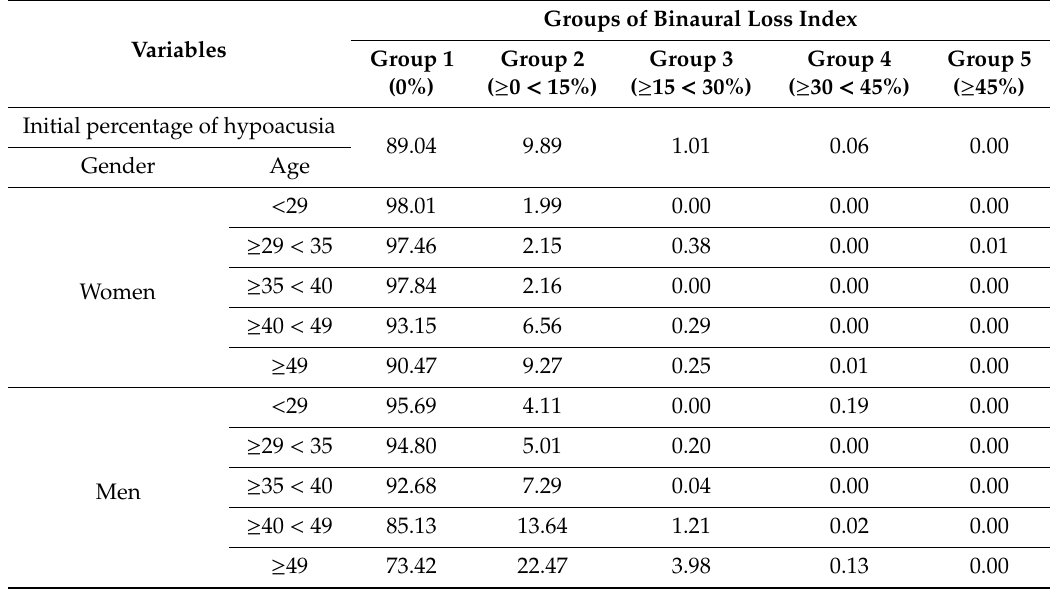
Table 5. Sensitivity analysis. Gender and age vs. Binaural Percentage Index. Source: Compiled by authors.